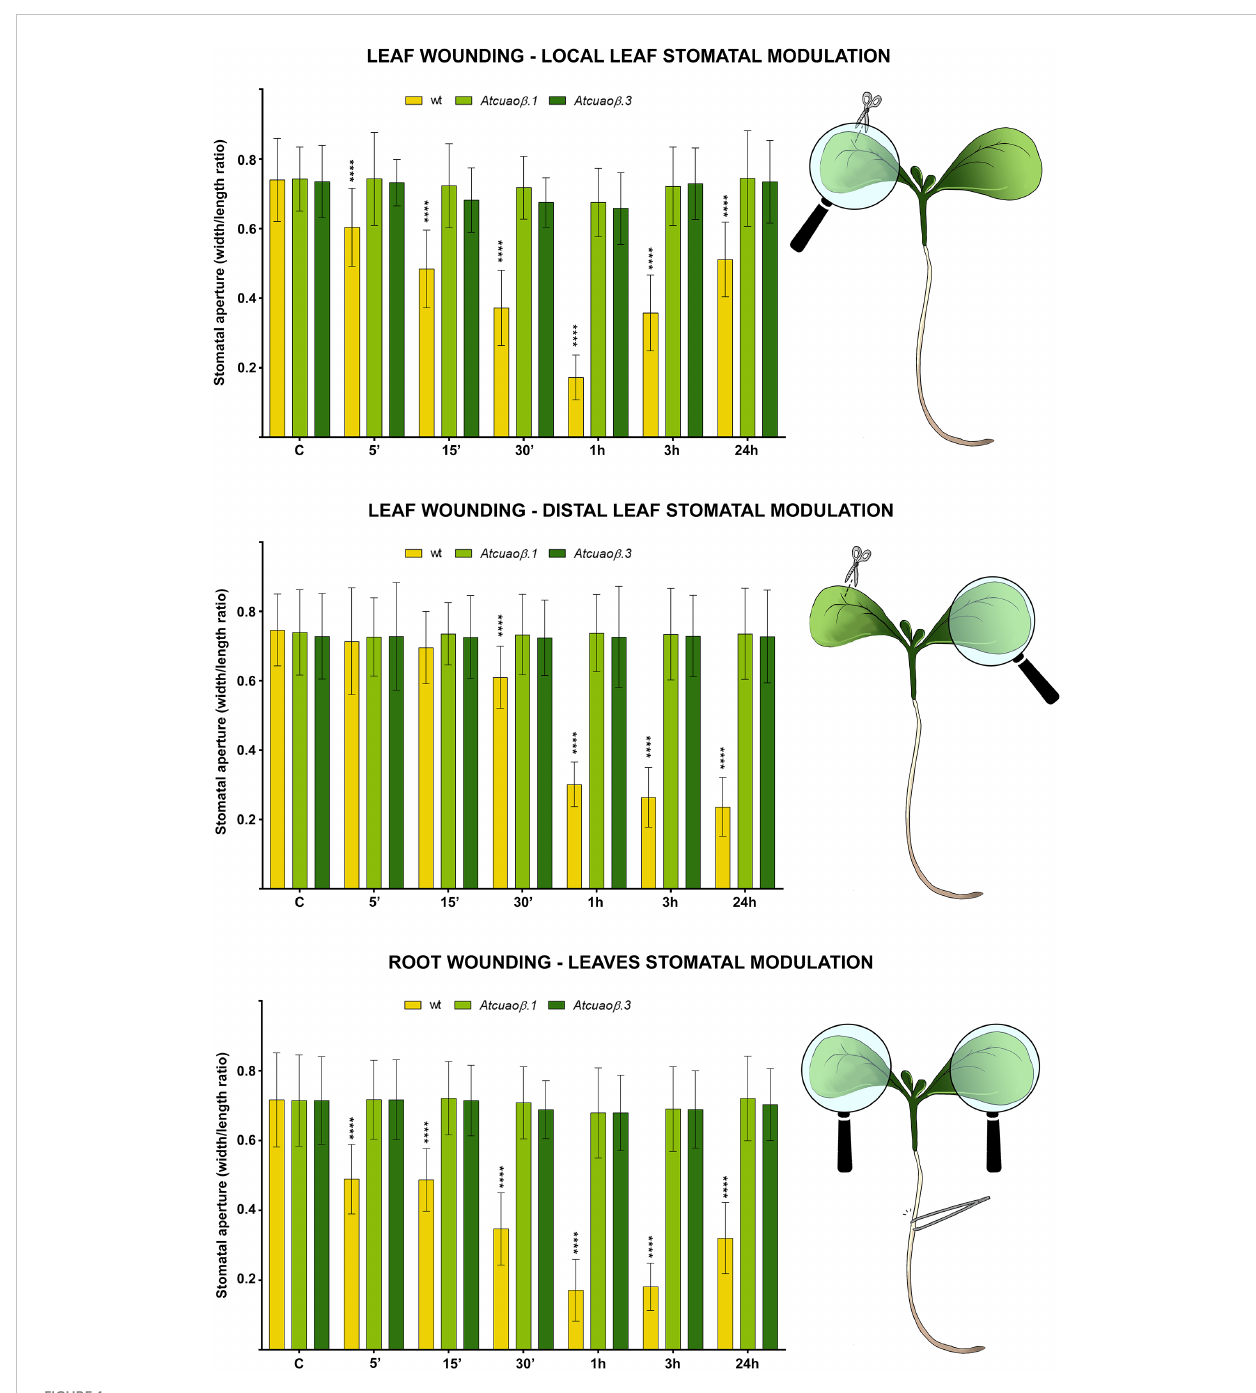
respect to unwounded seedlings between 30 min and 3 h (Figure S2 and Figure 5, top panel). As expected, DMTU treatment did not signi fi cantly affect stomatal aperture levels in Atcuao b seedlings neither after cotyledonary-leaf nor after root